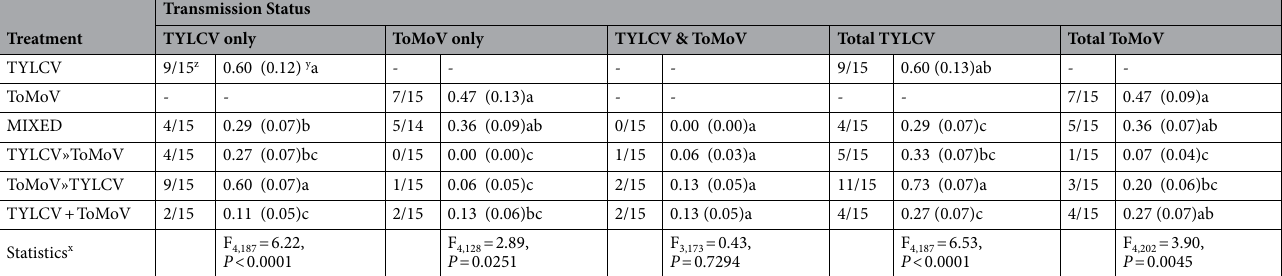
Table 3. The average proportion of sucrose sachets inoculated with TYLCV or/and ToMoV by whitefly cohorts. LS means comparisons among treatments were conducted using Tukey’s method at P = 0.05 level to compare the inoculation of viruses singly (TYLCV only, ToMoV only columns), together (TYLCV & ToMoV column), and sum of virus infection (Total TYLCV, Total ToMoV columns). z Total number of samples testing positive/total number tested. y Mean(Standard Error). x F Value, Num DF, Den DF, Pr > F. - No